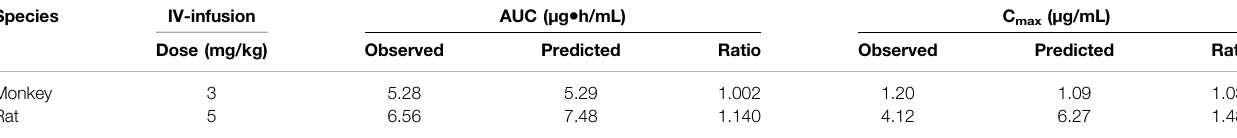
TABLE 5 | Predicted and observed pharmacokinetic parameters in rats and monkeys receiving IV infusion of ST-246. Species Dose (mg/kg)